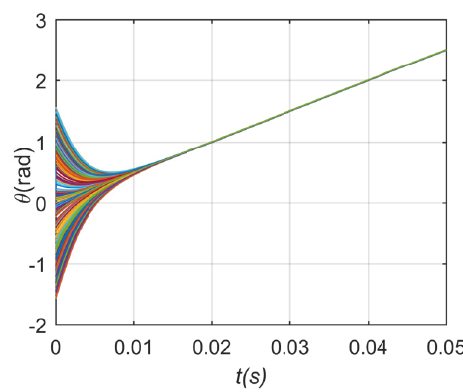
Figure 21. Phase stabilization process in case 3.